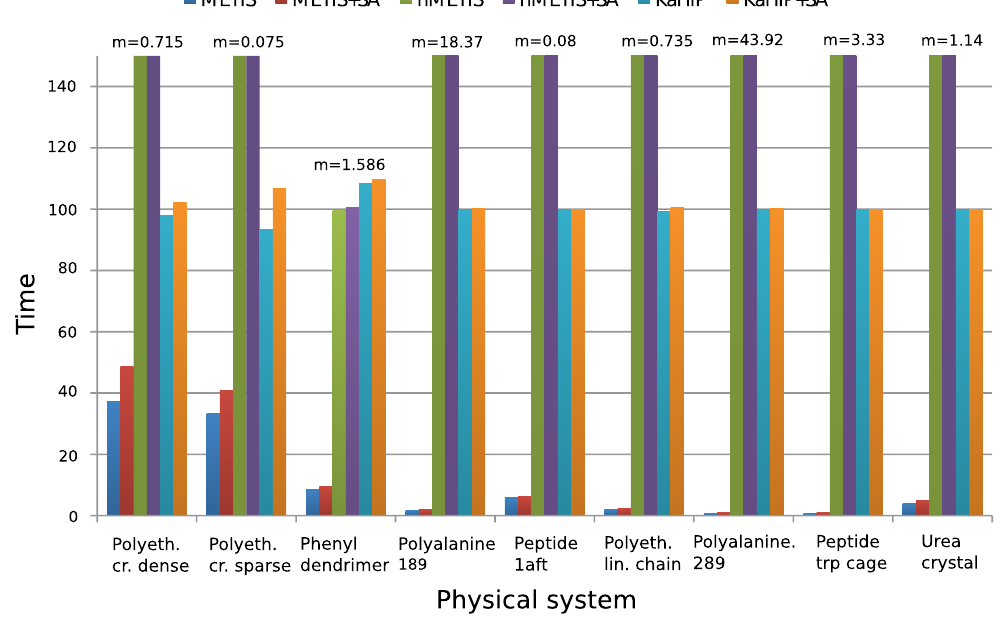
Figure 5. Computing time for partitioning. Test systems of Table 1. We use the formatting of Figure 4 to handle the big discrepancy between values for different graphs. Figure taken from [12]. Copyright